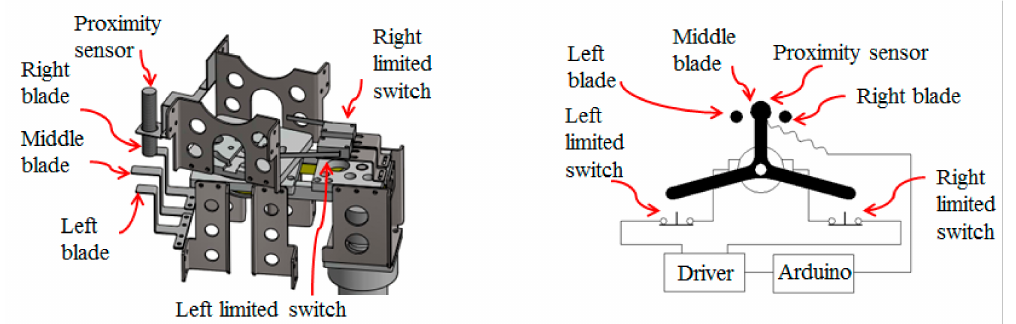
Figure 16. Sensor system to detect the azimuth of the swivel and the safety guard